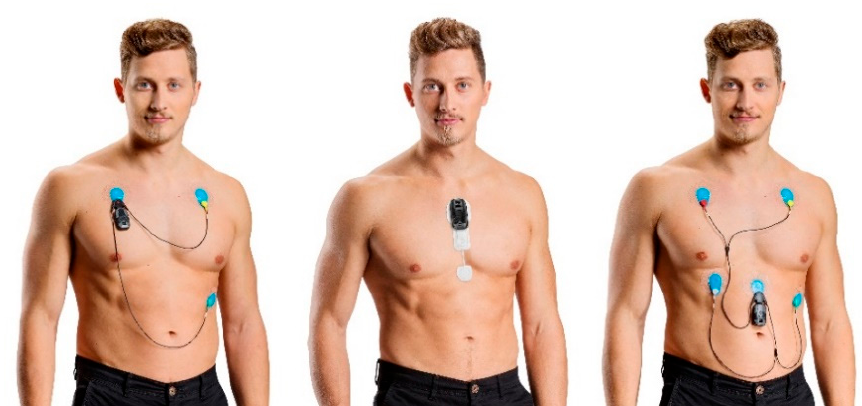
Figure 1. Bittium Faros TM 360 different configurations (image used with permission from Bittium [31]).